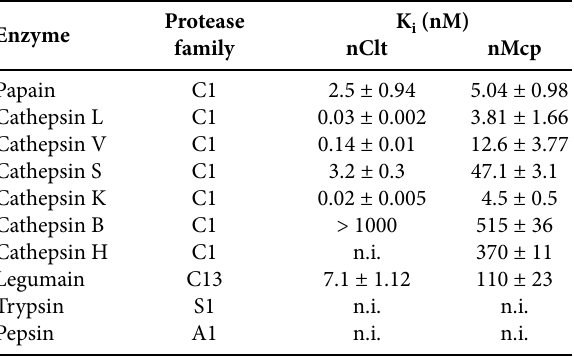
Table 4. Inhibition of various proteases by natural mycocypins. The kinetic data are as reported. 17 Standard deviations are given where appropriate. nMcp, natural macrocypin; nClt, natural clitocypin; n.i., no